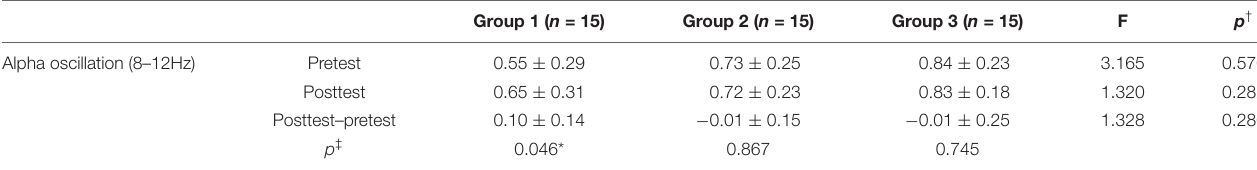
TABLE 3 | Comparison of power density of alpha oscillation before and after intervention in three groups [X ± SD ( µ V 2 /Hz)].